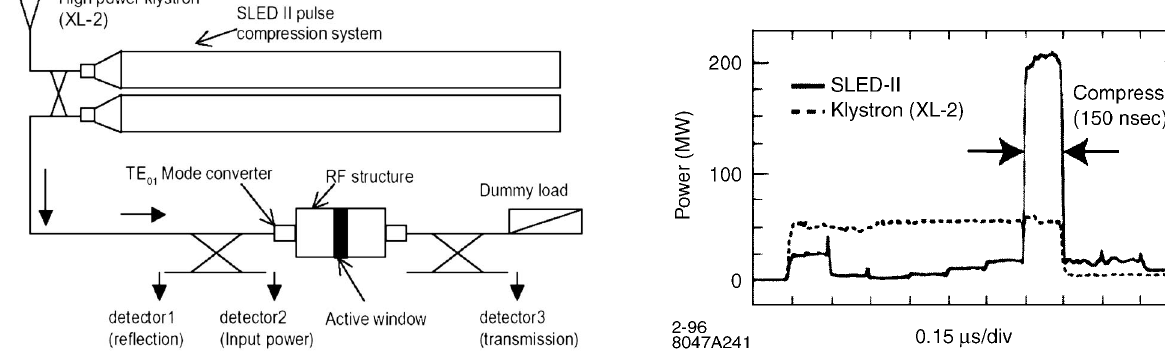
FIG. 19. Schematic diagram of the high power experiment. FIG. 20. SLED-II output